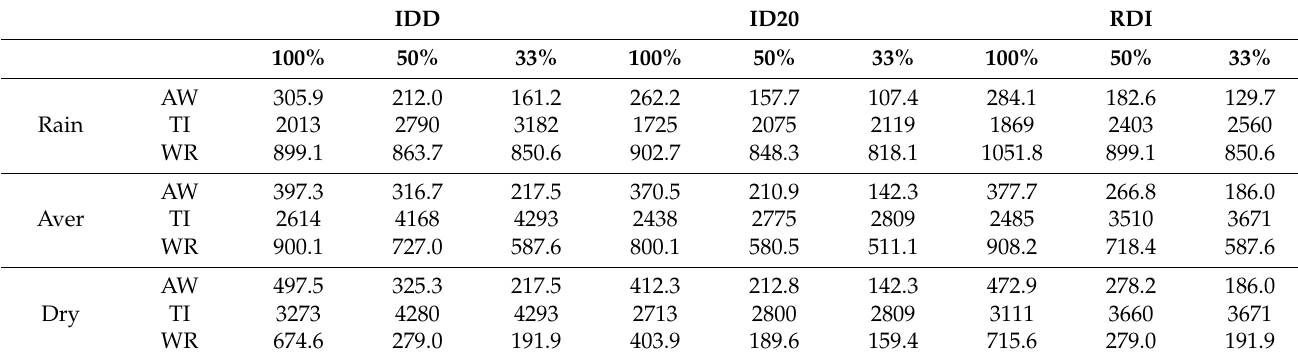
Table 2. Summary of applied water (AW, mm), seasonal time of irrigation (TI, hours), and water reserves (WR, mm) in the three rainfall conditions (rainy, average, and dry season), with the three irrigation schedules (daily, 20 days per month, and no irrigation in August (RDI)) in the three flow